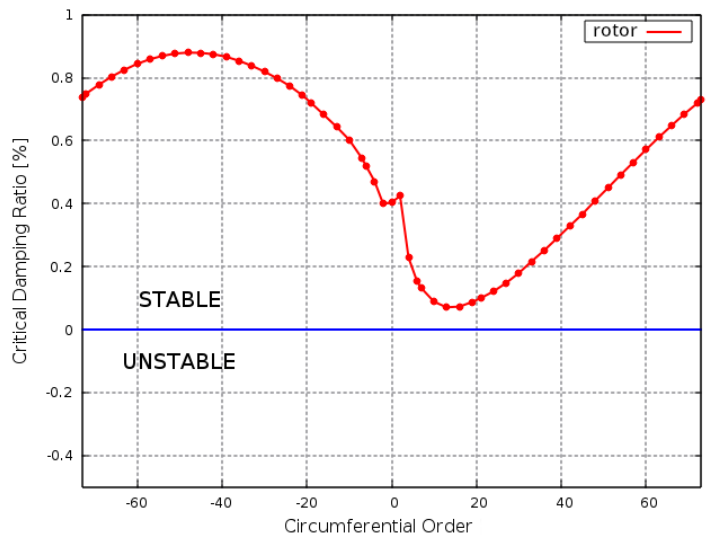
Figure 13. Critical damping ratio as a function of circumferential order for the bladed rotor. The small peak in the curve trend near (cid:96) = 0 is caused by the increase in the frequency values for the first bending mode at lower nodal diameters. This shift is due to the stiffening of the disk, as shown in Figure 7, which shows a typical trend of a bladed disk mode. The values corresponding to (cid:96) = + 7 (ND = − 7, backward) and (cid:96) = − 21 (ND = +